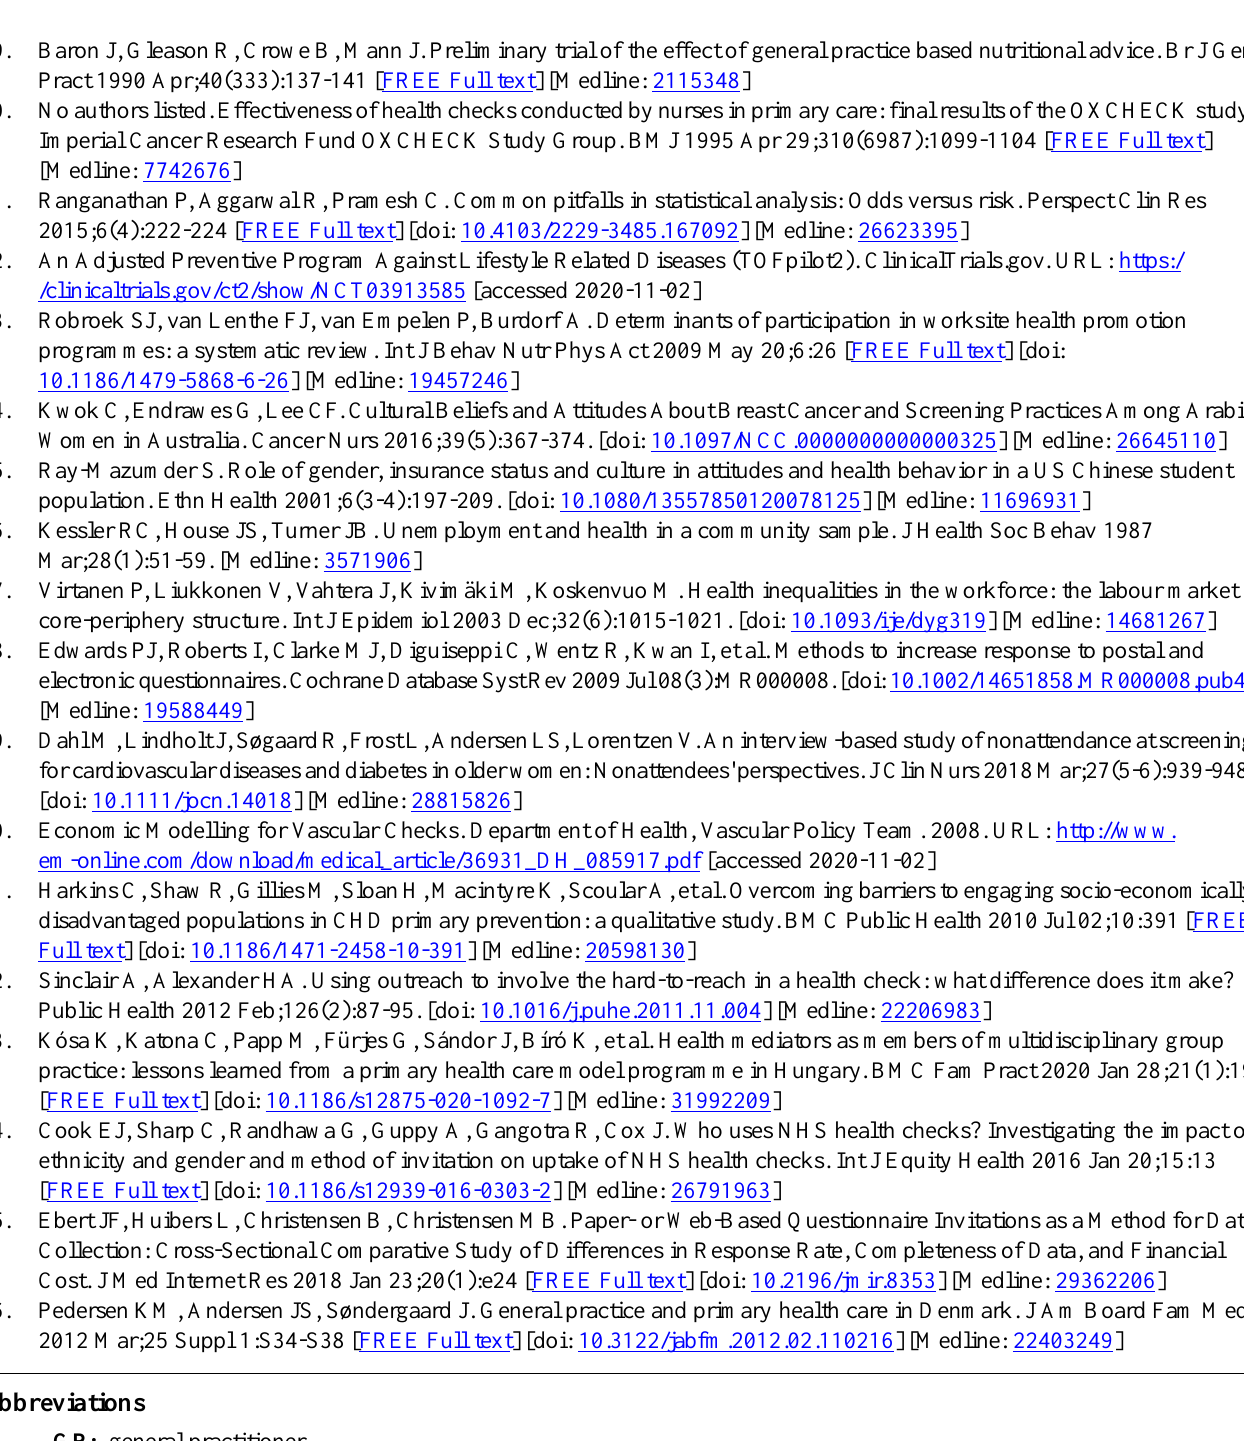
RR: risk ratio TOF: Early Detection and Protection Project (translated Danish